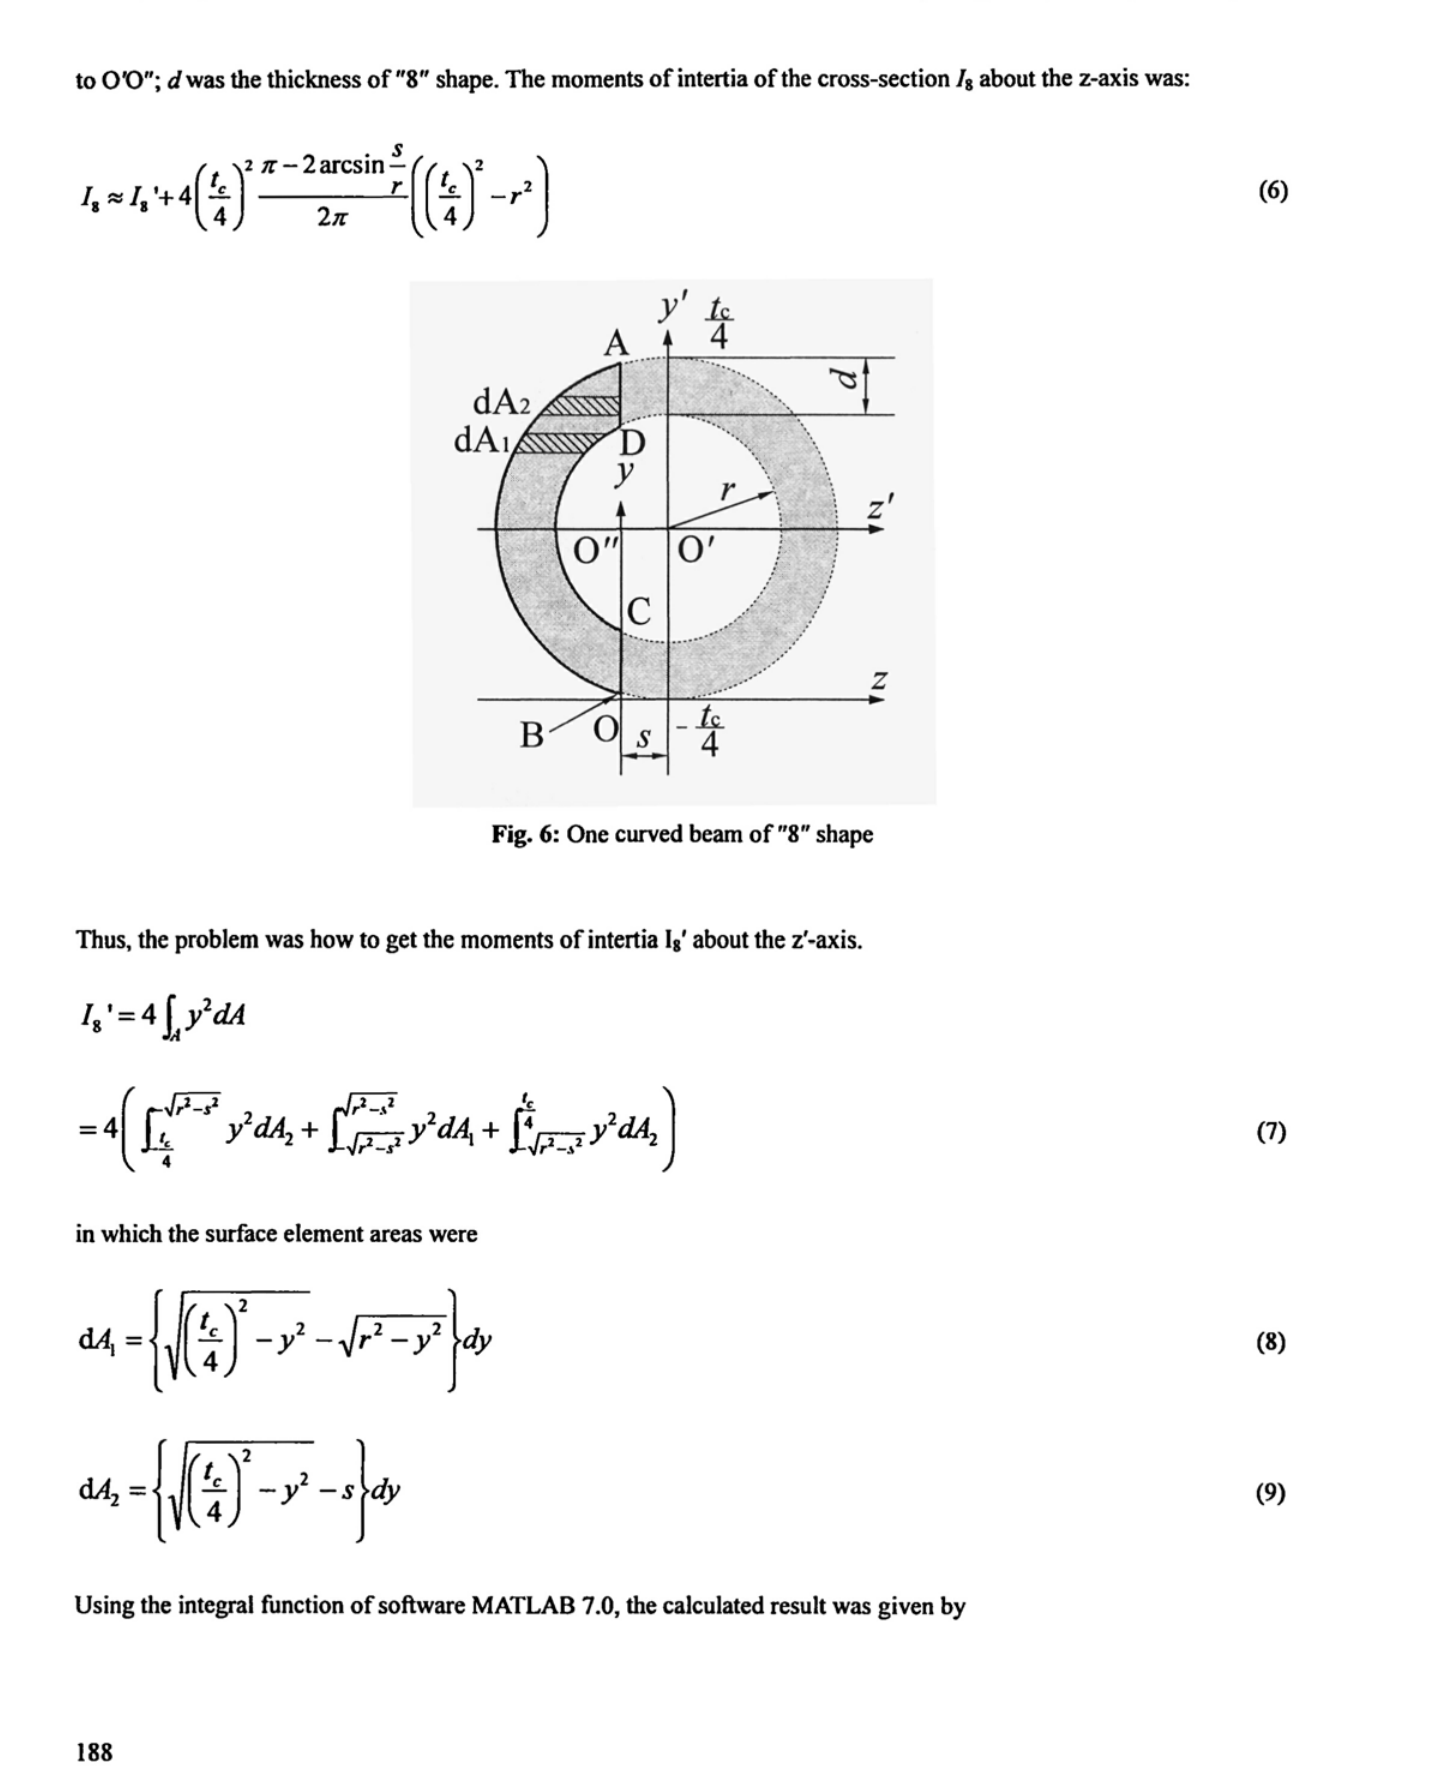
Fig. 6: One curved beam of "8"